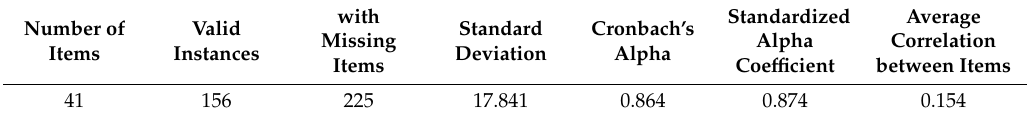
Table 3. Reliability verification of the questionnaire.